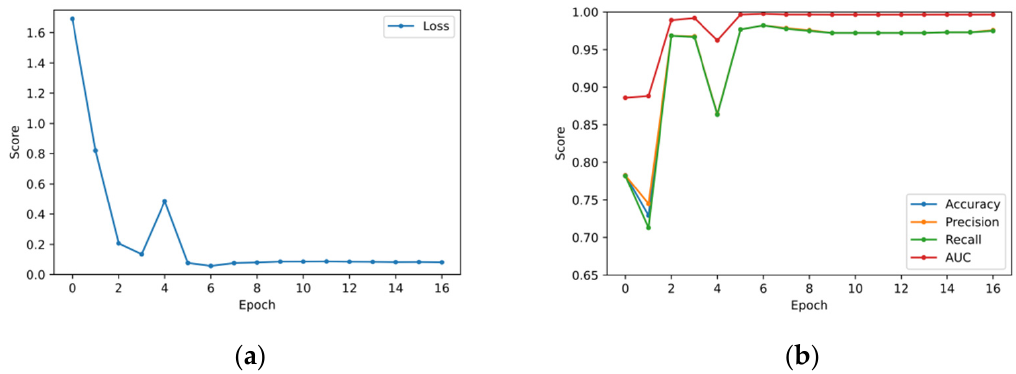
Figure 7. Metrics for validation set on training time: ( a ) Shows the value of the loss function; ( b ) shows the accuracy, precision, recall, and ROC AUC macro-averaged scores.